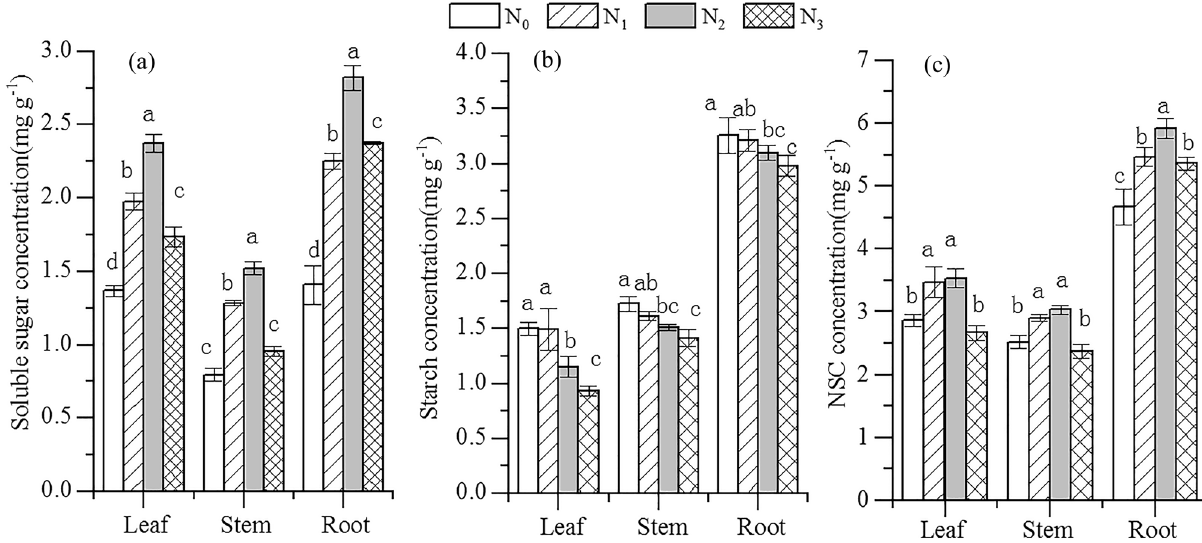
Figure 2. Effects of N addition on soluble sugar, starch, and NSC concentrations of R. soongorica . Error bars represent SE (n = 6). Different lowercase letters above bars indicate significant differences at P <